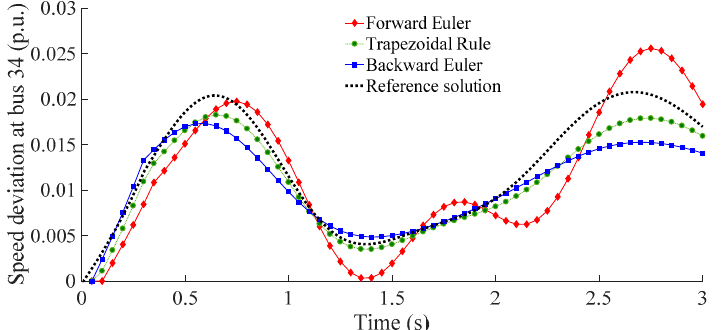
Figure 7. Rotor speed deviation at the generator at bus 34 when a short circuit at bus 16 and a integration time step of 0.05 s.